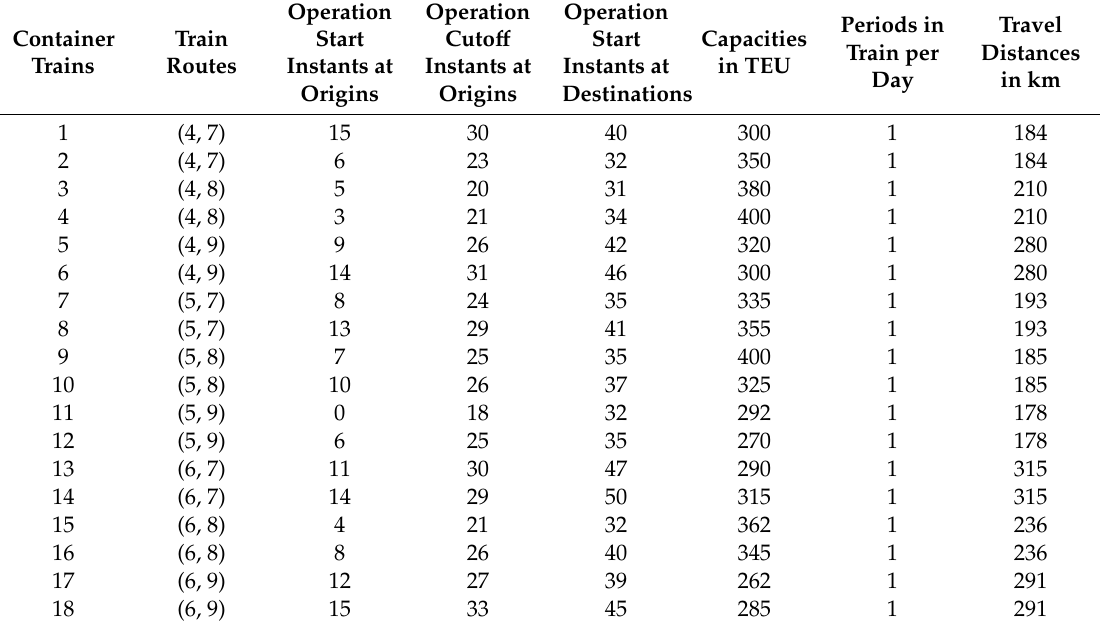
Table 2A. The capacities, travel times, and travel costs of the container truck fleet groups in the network.